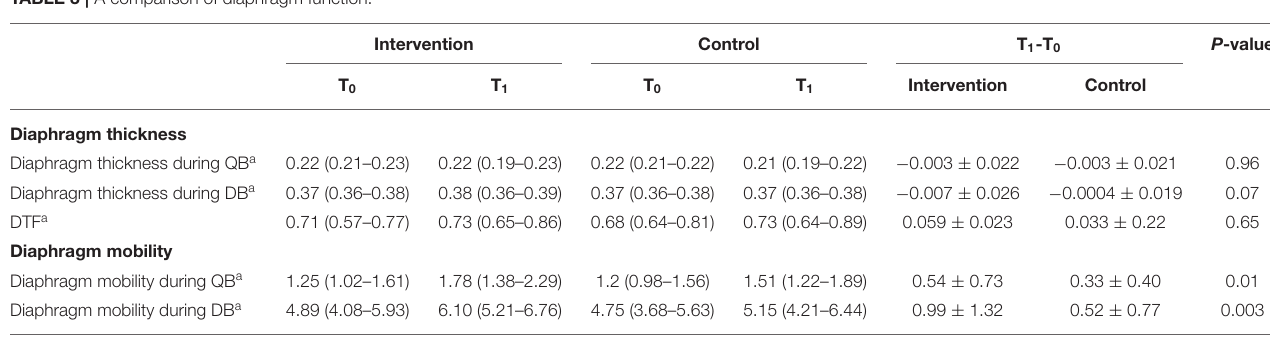
TABLE 3 | A comparison of diaphragm function.